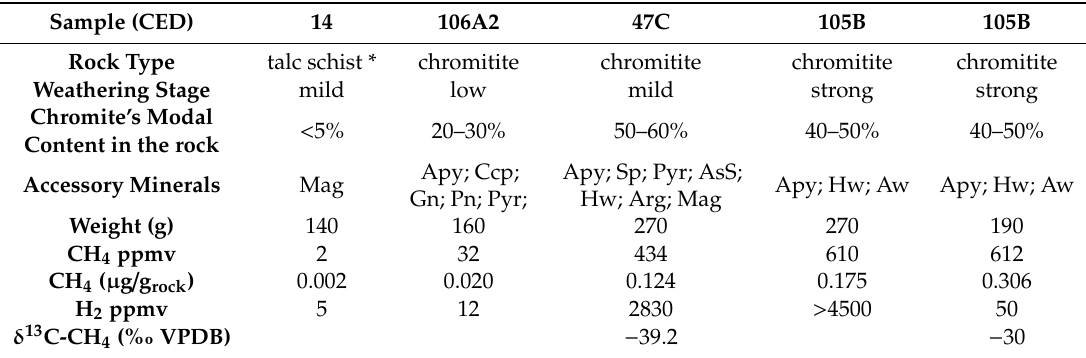
Table 1. Concentration of CH 4 , H 2 and stable C isotopic ratio of CH 4 in the gas extracted from Cedrolina samples. The main mineralogical data for each sample are also